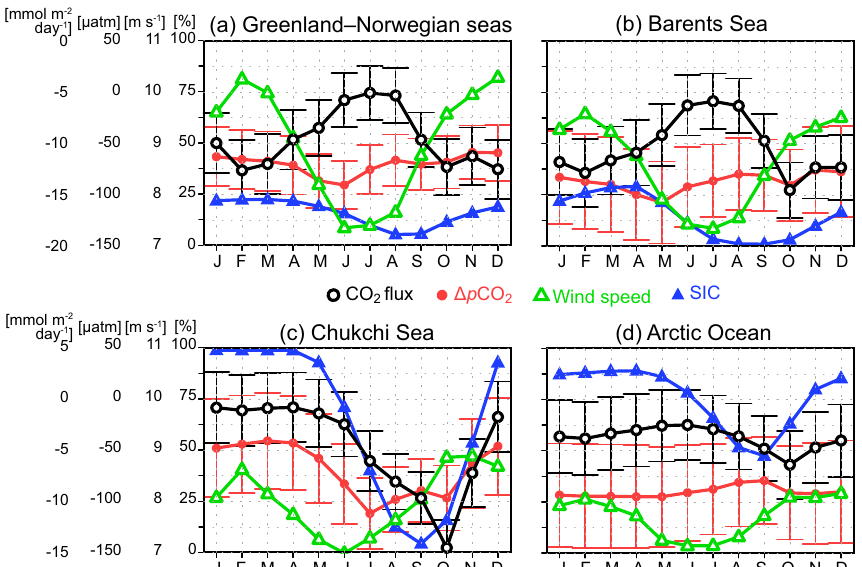
Figure 10. The 18-year monthly mean CO 2 flux (mmolm − 2 day − 1 , black), (cid:49)p CO 2 (µatm, red), wind speed (ms − 1 , green), and SIC (%, blue), averaged over (a) the Greenland and Norwegian seas, (b) the Barents Sea, (c) the Chukchi Sea, and (d) the Arctic Ocean. Error bars indicate the uncertainty.